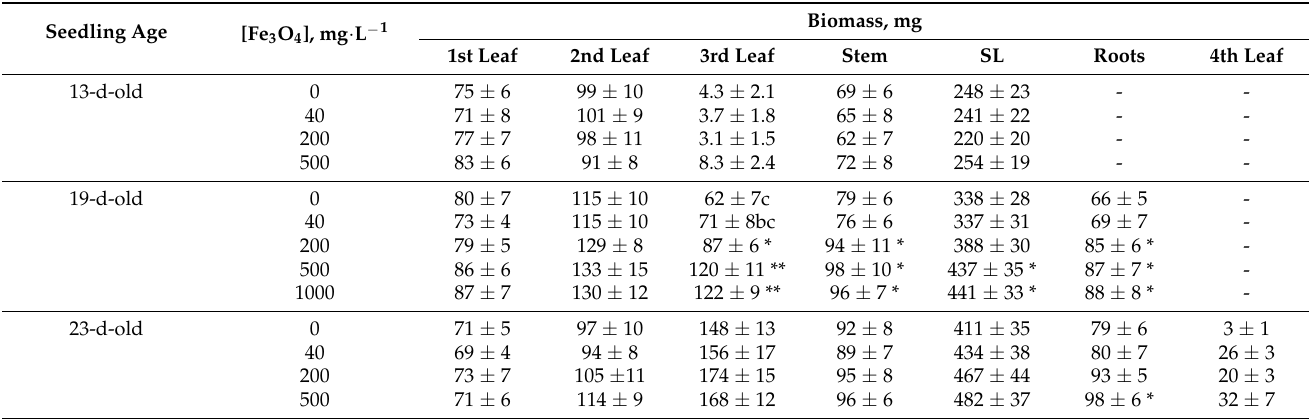
Table 1. Effect of seed treatment with various concentration of Fe 3 O 4 nanoparticles on the fresh weight of various organs of wheat plants during their cultivation under high (300 µ mol (photons) m − 2 · s − 1 ) light intensity. SL − stem + leaves. Means ± SD ( n = 5).